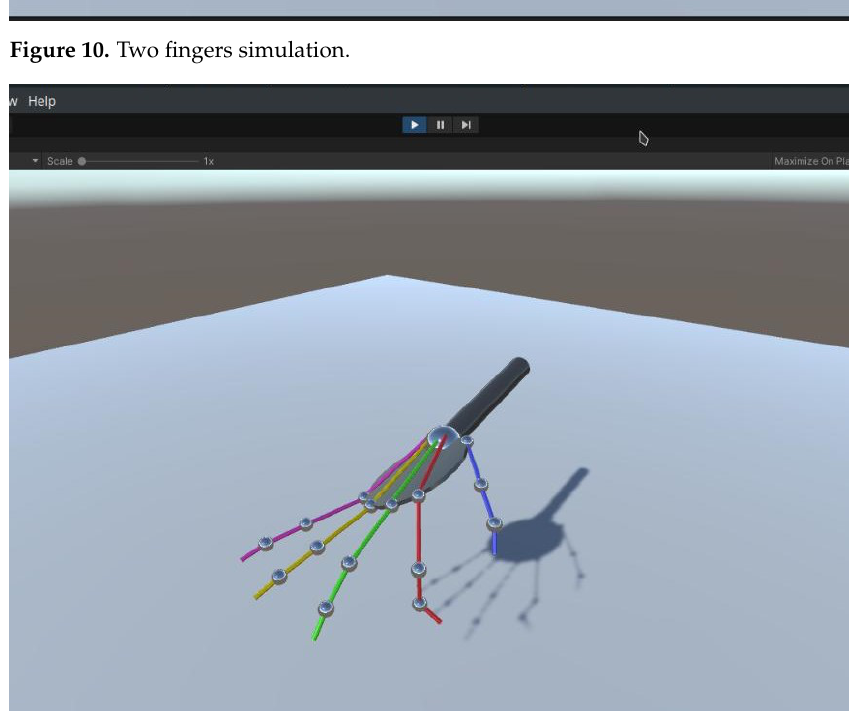
Figure 11. Index and thumb connected